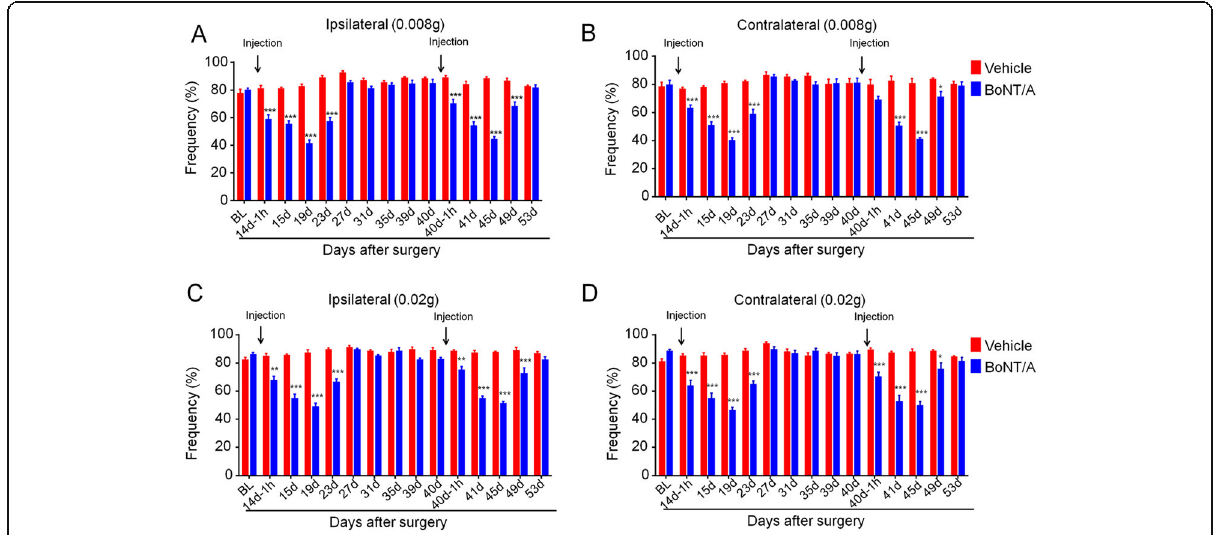
Fig. 2 Unilateral facial injection of BoNT/A attenuated bilateral mechanical pain hypersensitivity induced by dIoN-CCI surgery in mice. Black arrow represented the time of BoNT/A injection in mice. a - b At 0.008 g von Frey stimulation intensity, facial injection of BoNT/A significantly attenuated ipsilateral ( a ) and contralateral ( b ) mechanical pain hypersensitivity induced by dIoN-CCI surgery in mice, which lasted approximately 9 days, compared to the vehicle group. After 2 weeks, a second injections of BoNT/A showed the similar analgesic effect. c - d At 0.02 g von Frey stimulation intensity, facial injection of BoNT/A significantly attenuated ipsilateral ( a ) and contralateral ( b ) mechanical pain hypersensitivity induced by dIoN-CCI surgery in mice, which lasted approximately 9 days, compared to the vehicle group. After 2 weeks, a second injections of BoNT/A showed the similar analgesic effect. Data was expressed as Mean ± SEM. ( n = 8 each group, * P < 0.05, ** P < 0.01, *** P < 0.001, two-way ANOVA with post-hoc Bonferroni test). dIoN-CCI, chronic constriction injury of distal infraorbital nerve; BoNT/A botulinum toxin A; BL,